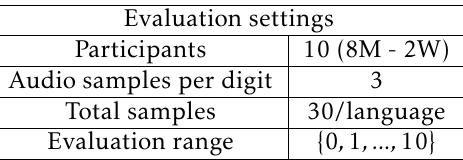
Table 2. Human assessment settings.